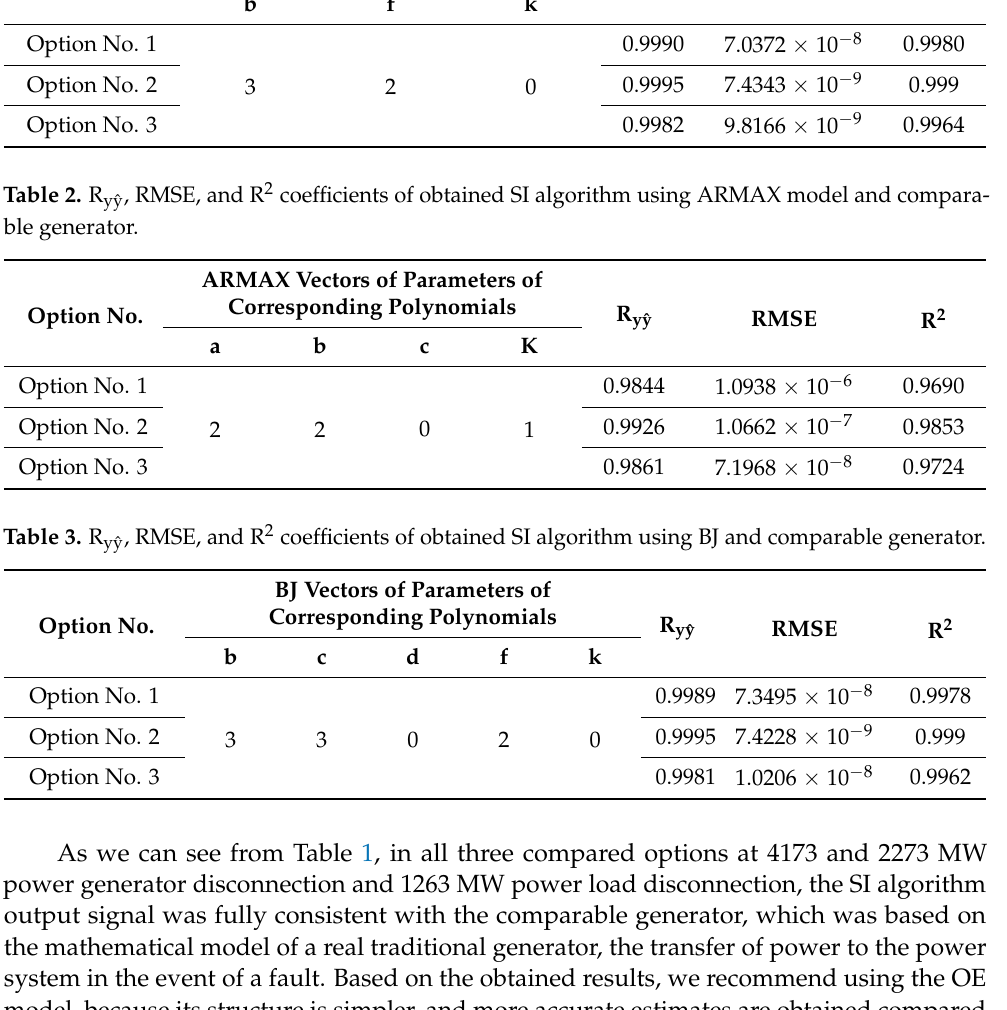
Table 1. R yˆy , RMSE, and R 2 coefficients of obtained SI algorithm using OE model and compara- ble generator.